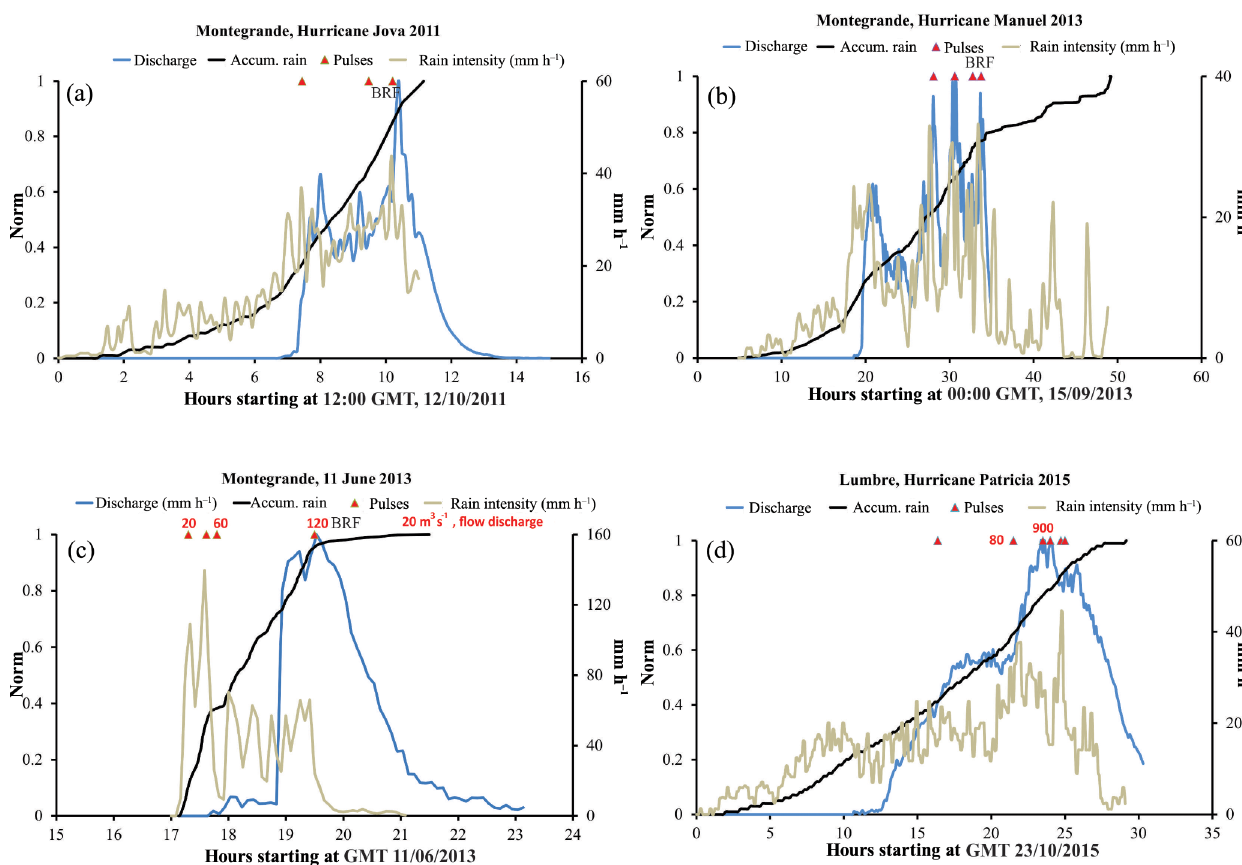
Figure 9. Diagrams showing the main lahar pulses (red triangles) as detected from the seismic signal of the analyzed events in relation with the accumulated rainfall (dark line), rainfall intensity (10mh − 1 ) (gray line) and simulated watershed discharge (blue line) for the following hydro-meteorological events (a) Jova; (b) Manuel; (c) 11 June 2013; and (d)